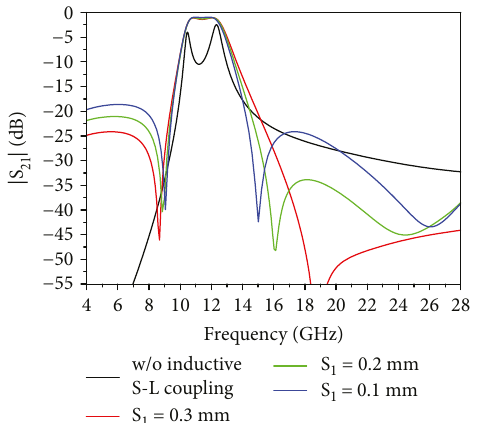
Figure 5: Simulated frequency responses without inductive source-load coupling and with inductive source-load coupling at various S . 1